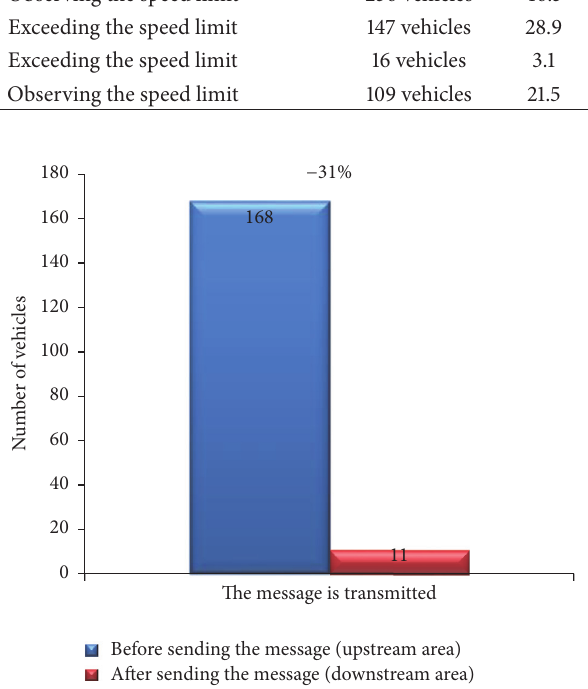
Figure 12: The effect of the VSS on exceeding the speed limit by 20 km/h or more.